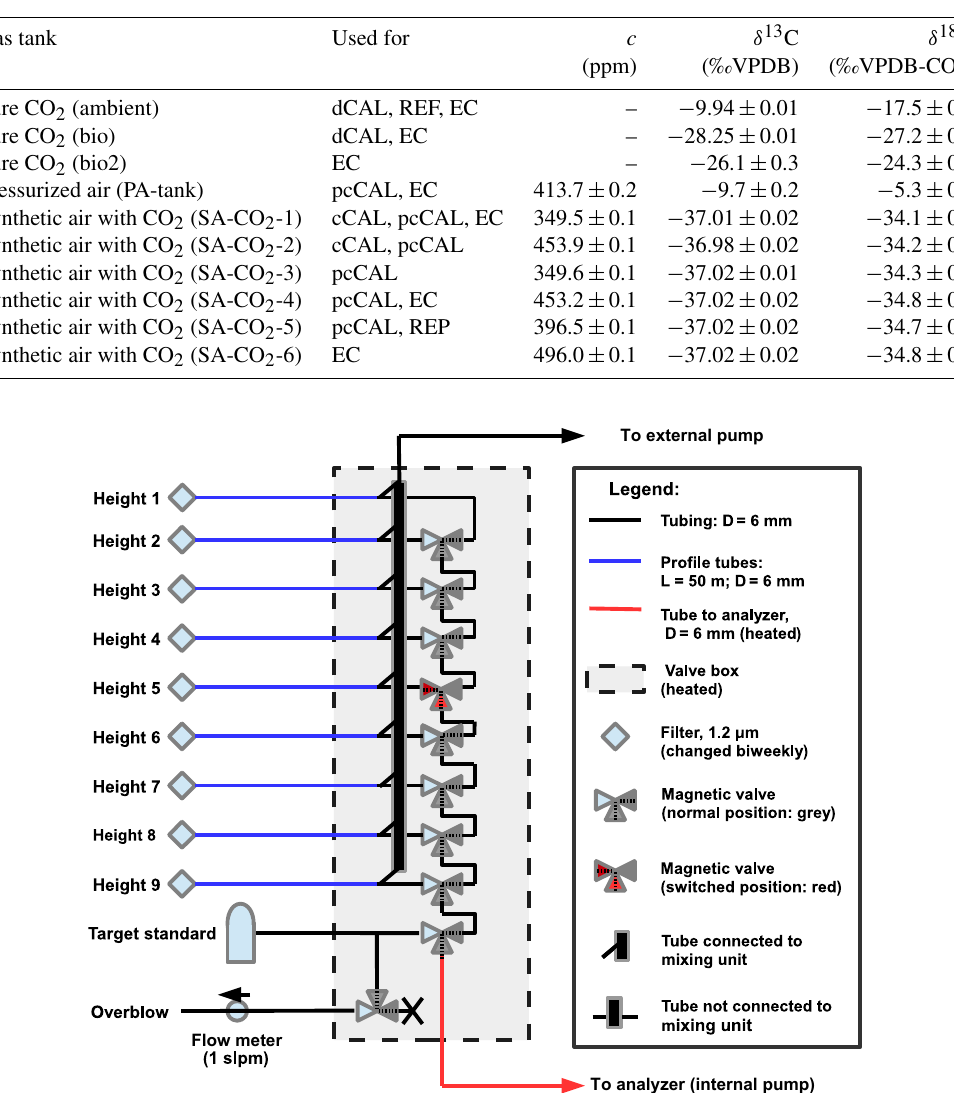
Figure 2. Plumbing scheme for the measurements of nine heights and a target standards; the example shows the valve positions when height 5 is